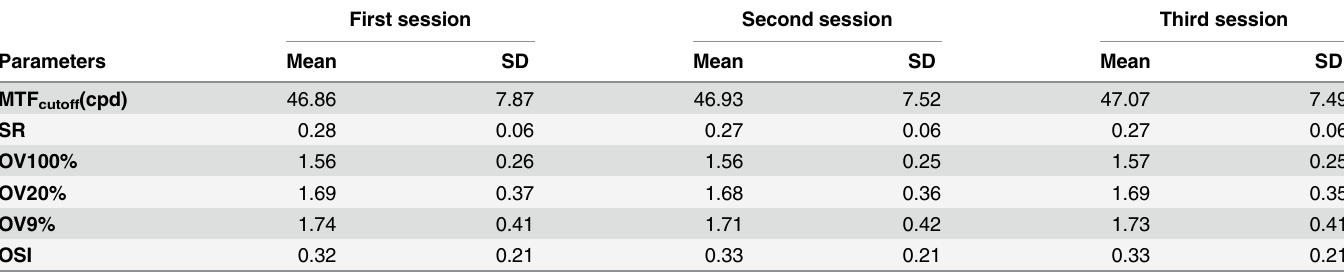
Table 1. Mean and SD for the parameters in each of the three sessions.